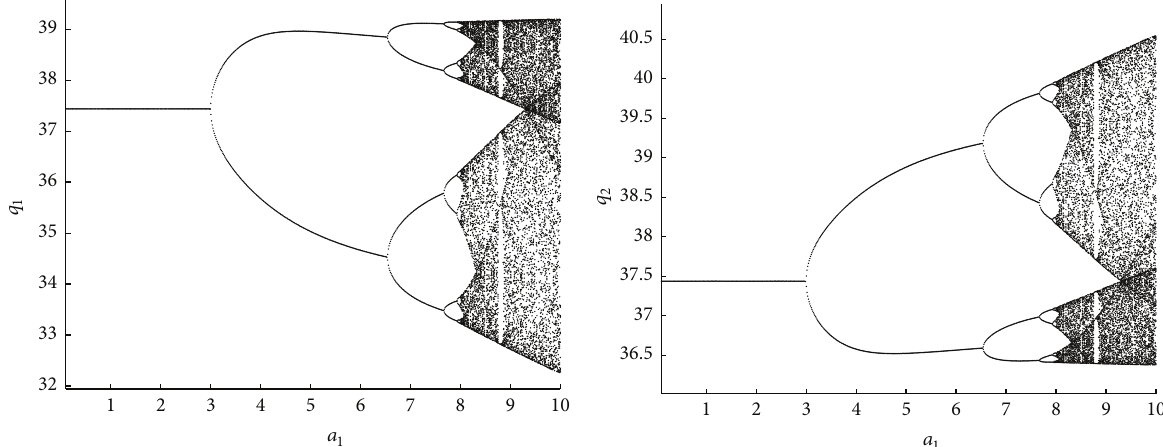
Figure 4: Bifurcation diagrams of quantities 𝑞 1 and 𝑞 2 with respect to the upper bound of production variation 𝑎 1 . Increasing 𝑎 1 leads to instability.